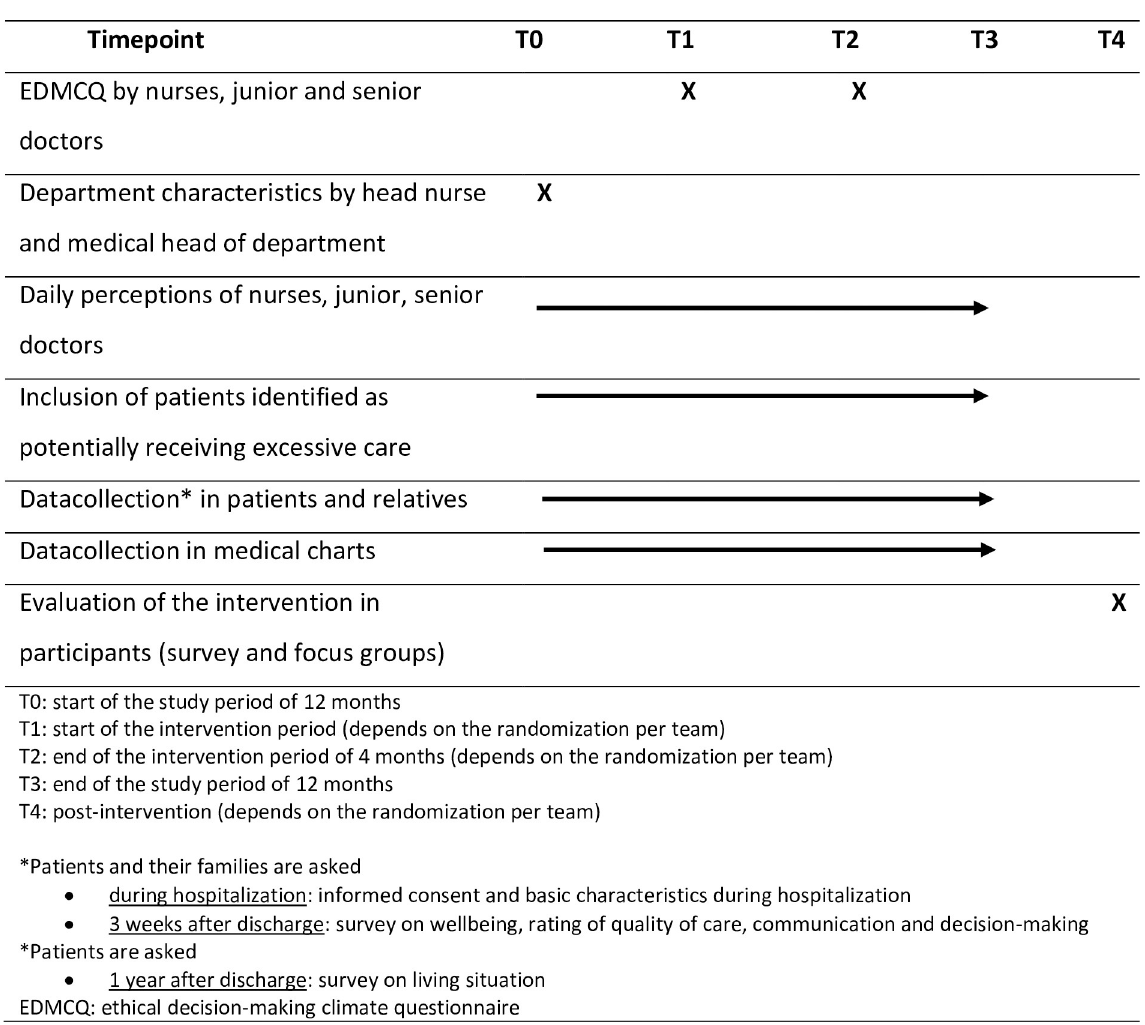
Fig 1. Schedule of enrolment, interventions and